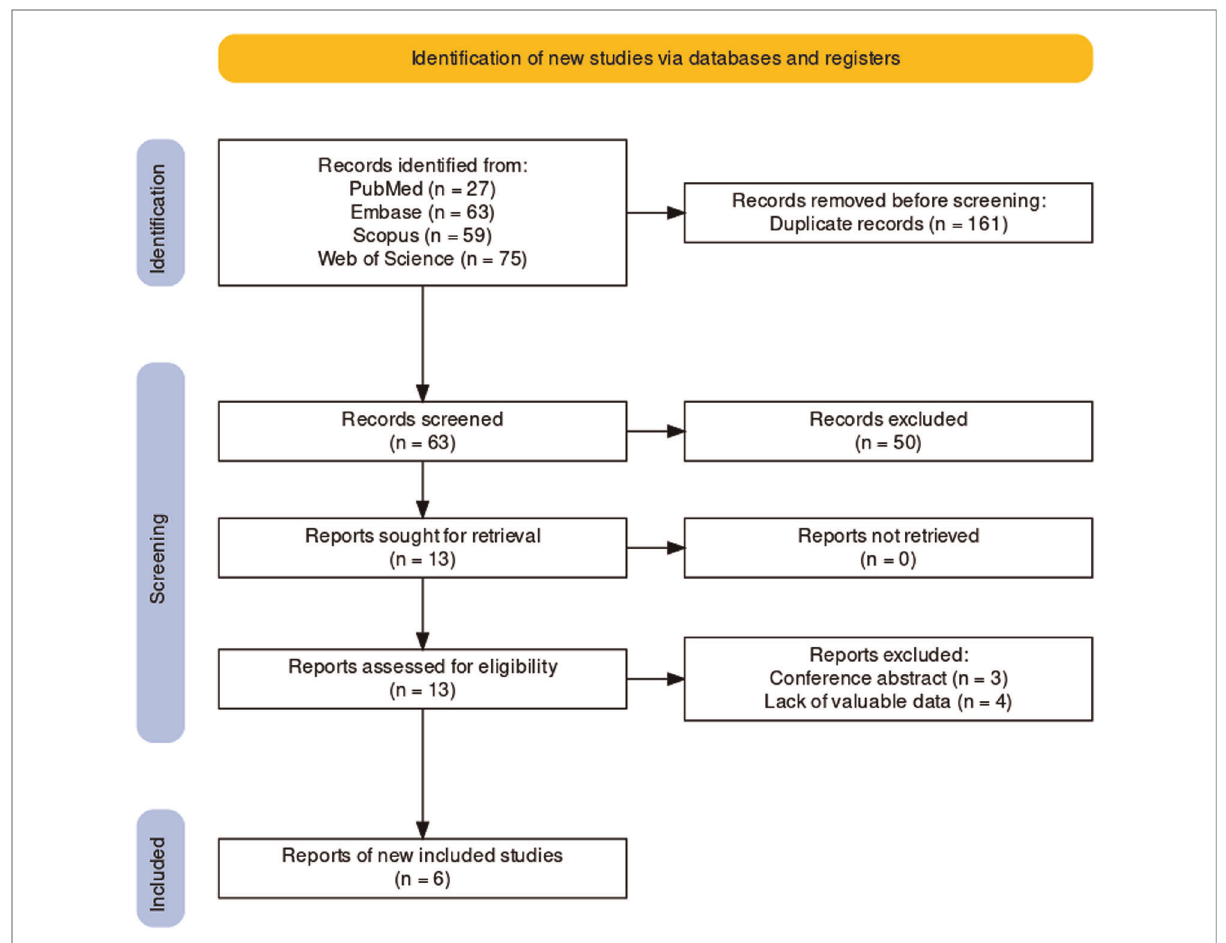
FIGURE 1 Flowchart of the literature